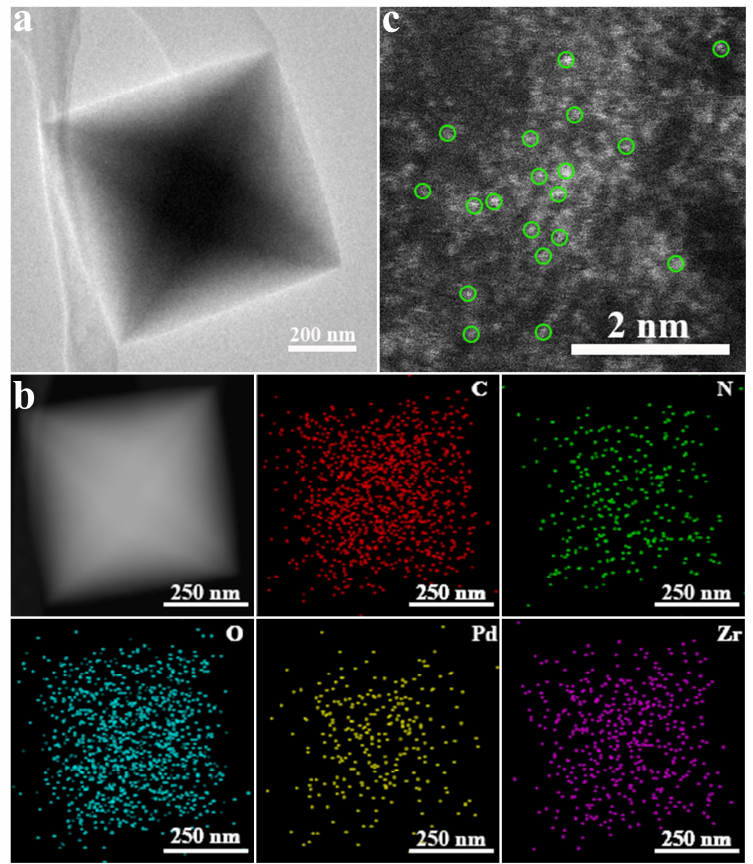
Figure 1. ( a ) TEM, ( b ) EDS elemental mapping, and ( c ) HAADF-STEM image of Pd@ZrO 2